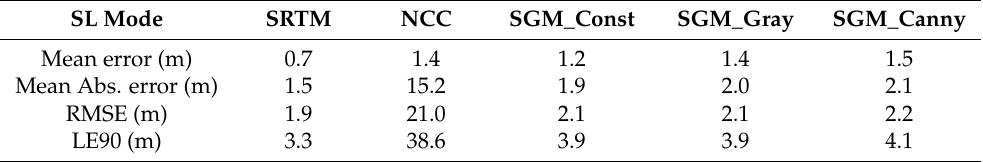
Table 8. Height accuracy of DSM generated from Spotlight stereo pair in test area 3.